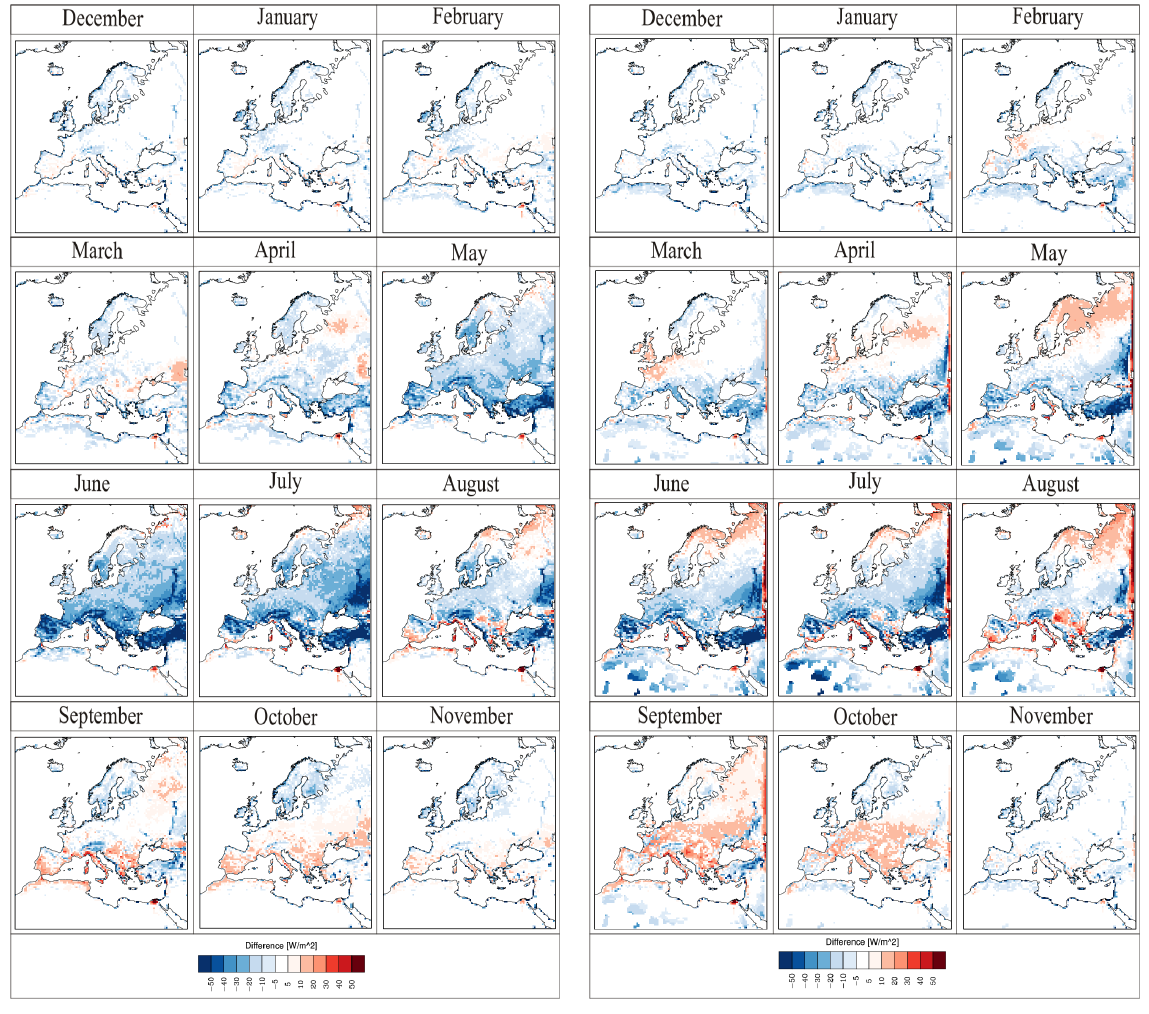
Figure 6. Differences of surface latent heat flux of REMO2009 vs. FLUXNET and REMO-iMOVE vs. FLUXNET in the period 1995 to 2001